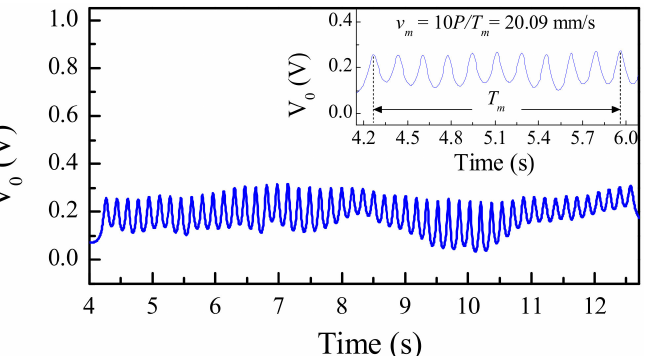
Figure 16. Measured envelope function for the fabricated 50-aperture encoder of Figure 15. Reprinted with permission from [25]. Copyright 2020 IEEE.